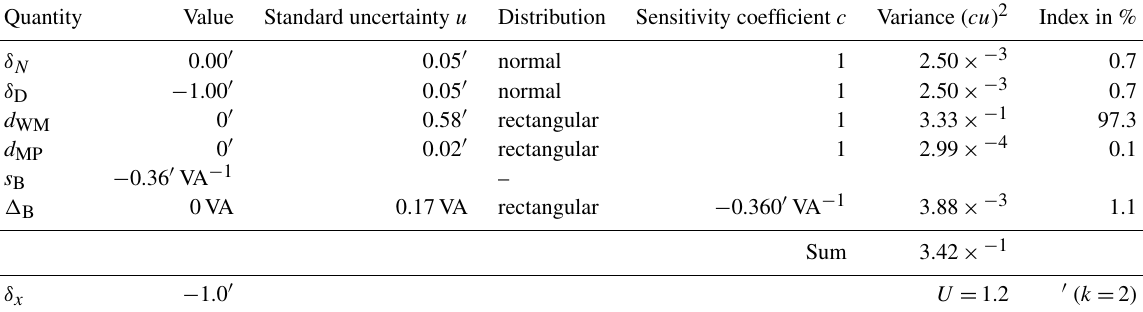
Table 4. Uncertainty budget of the phase displacement for a class 0,2S instrument transformer at 100% I n and S n = 10VA. Quantity Value Standard uncertainty u